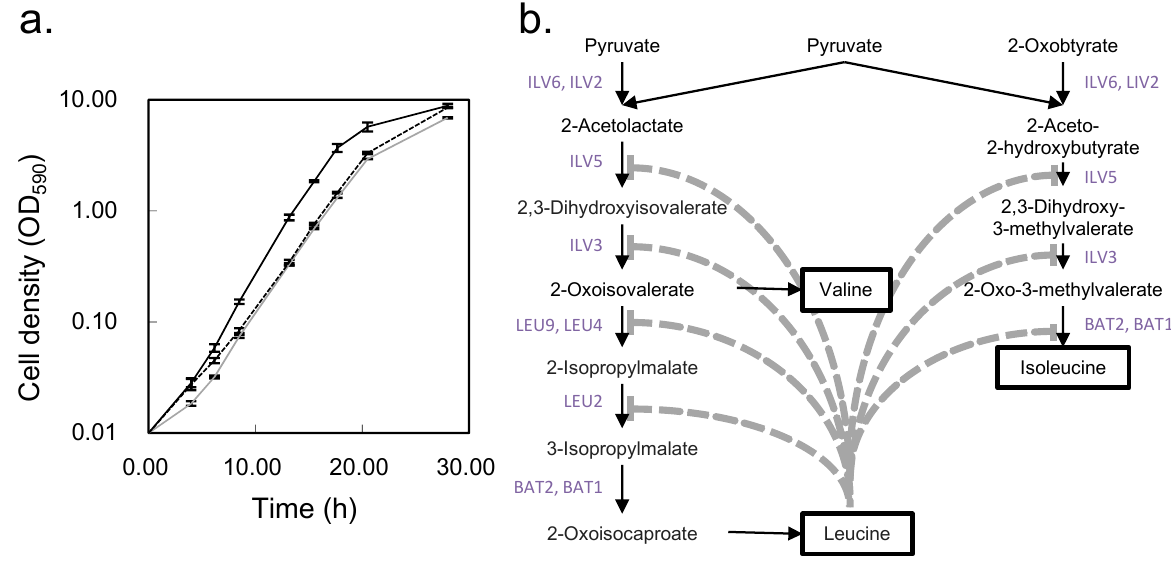
Figure 6. Growth curve and metabolic pathway of branched chain amino acid biosynthesis of S. cerevisiae . ( a ) Growth curve of each sample. The horizontal axis indicates the sampling time, and the vertical axis indicates the cell density on a logarithmic scale. The black, dotted, and gray lines indicate BY4742 under synthetic dextrose (SD) medium with amino acid supplement, X2180 under SD medium with amino acid supplement, and X2180 under SD medium without amino acid supplement, respectively; ( b ) Metabolic pathway of valine, leucine, and isoleucine in S. cerevisiae (29). Capital letters indicate the corresponding enzymes for the reactions. Dotted lines indicate feedback inhibition by